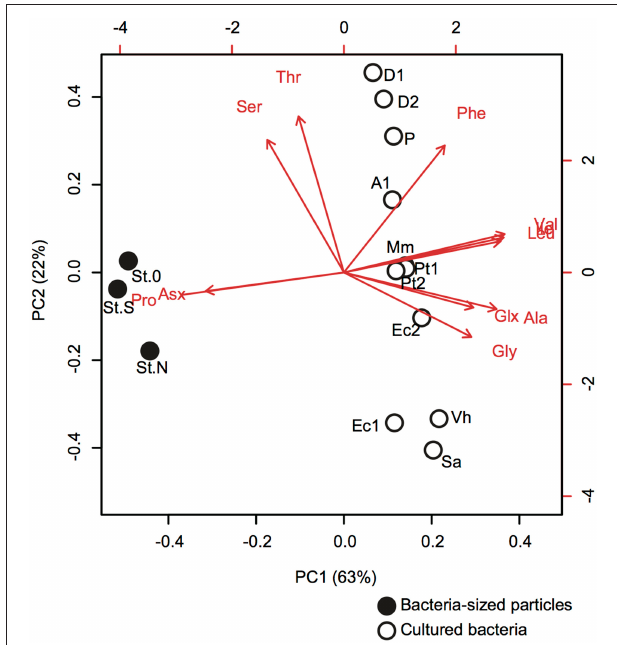
FIGURE 5 | Principal component analysis (PCA) of the AA compositions of bacteria-sized particles (closed symbols with station codes) and cultured bacteria (open symbols with strain codes). The biplot of the first two PCA axes (PC1 and PC2) shows site scores and variable loadings (red arrows). AA abbreviations are the same as in Figure 2 . For cultured bacteria, we used our own data obtained for E. coli (Ec1, this strain code corresponds to the label in the figure) and V. harveyi (Vh) ( Table 6 ), and data reported in the literature (Brown et al., 1996; Okayasu et al., 1997). For this comparison, we used the data, including those on proline content, in the literature and considered only 11 amino acids quantified for bacteria-sized particles. The data in the literature consisted of nine isolated bacterial strains grown in the laboratory: [ E.coli (Ec2)], Gram-positive [ Staphylococcus aureus (Sa)] and marine bacteria [ Aeromonas sp. ACM4771 (A1), Derxi a sp. ACM 4722 (D1), Derxia sp. ACM 4773 (D2), Methylophilus methylotrophus NCIB 10515 (Mm), Pseudomonas testosterone ACM 4768 (Pt1), Pseudomonas testosterone ACM 4769 (Pt2), and Pseudomonas sp. ACM 4770(P)]. Statistical parameters are given in Supplementary Table